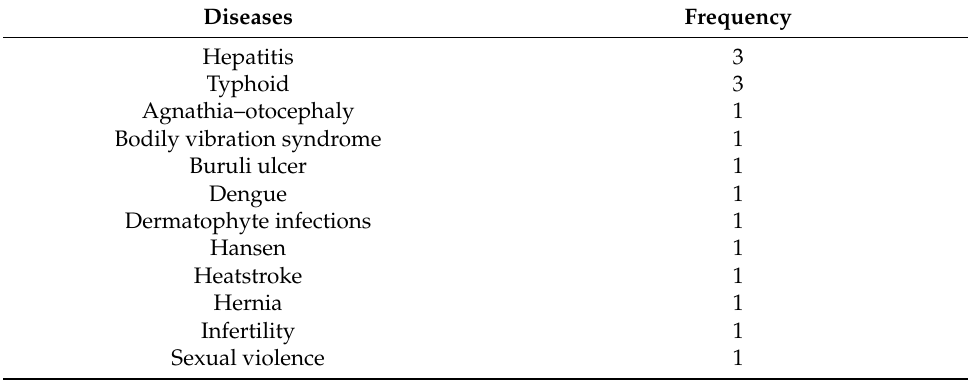
Table A6. Profile of communicable and non-communicable diseases reported in less than four studies,